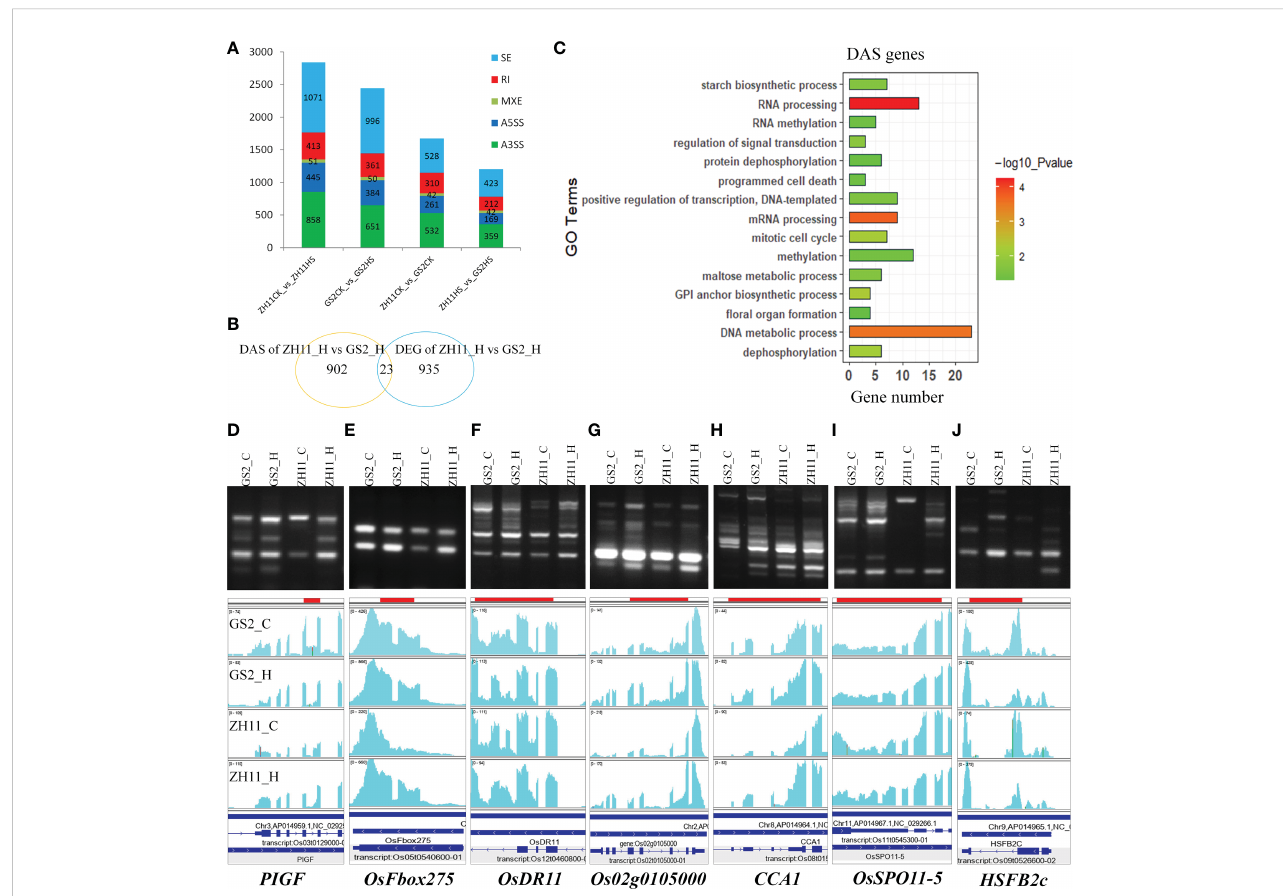
FIGURE 7 Detection of differential alternative splicing (DAS) genes in Zhonghua 11 (ZH11) and grain size on chromosome 2 (GS2). (A) Number of DAS events in four different comparisons. (B) Overlap of differentially expressed genes (DEGs) and DAS genes in the comparison of the ZH11 HS group and the GS2 HS group. (C) Gene ontology (GO) analysis of DAS genes in the comparison of the ZH11 HS group and the GS2 HS group. (D – J) Alternative splicing (AS) events on seven genes as determined through reverse transcription-PCR (RT-PCR) (upper) and the IGV program